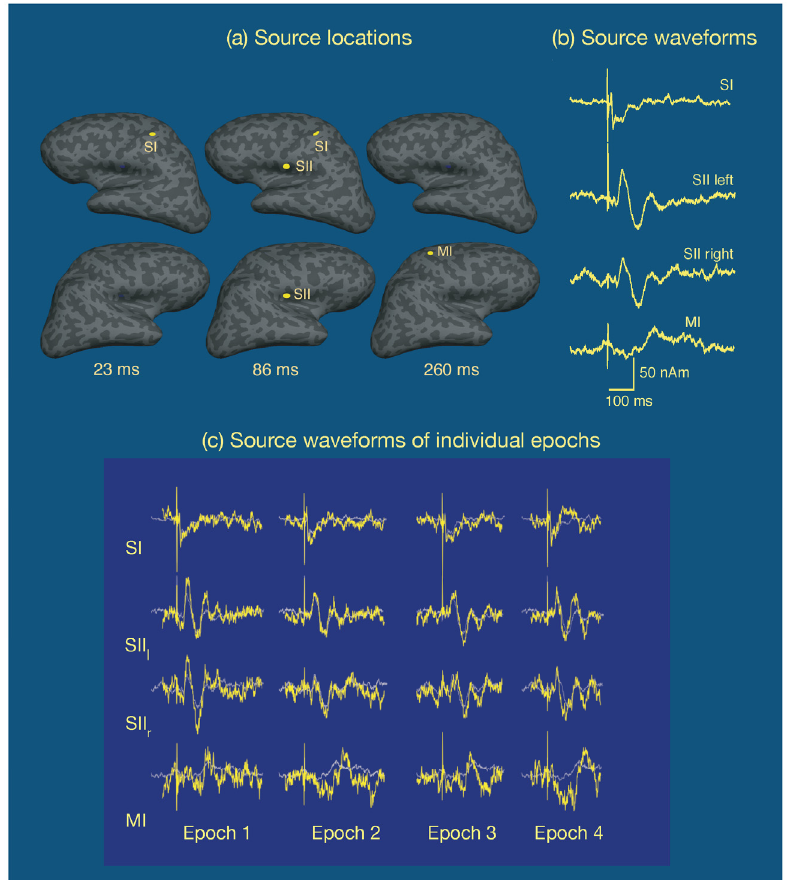
Figure 8. Multidipole model of activity in the somatosensory system. ( a ) Estimated locations of somatosensory and motor sources visualized on the inflated representation of the cortex at three time points during the epoch. ( b ) Estimated time courses of the four sources. The vertical line in each trace denotes time of stimulus delivery. ( c ) Estimated source time courses for four individual epochs assuming that the source locations and orientations are the same as those determined from the average responses. Light blue: the source time courses calculated from the average. Yellow: the source waveforms based on individual epochs.